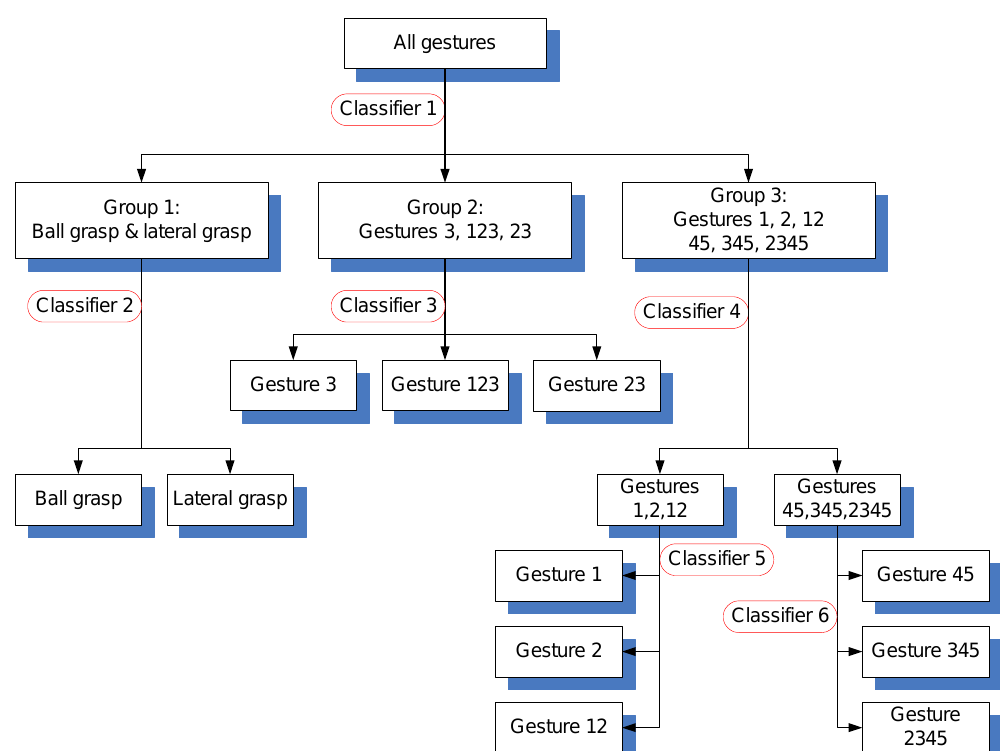
Figure 9. Configuration of the cascaded-classifier of the first subject.